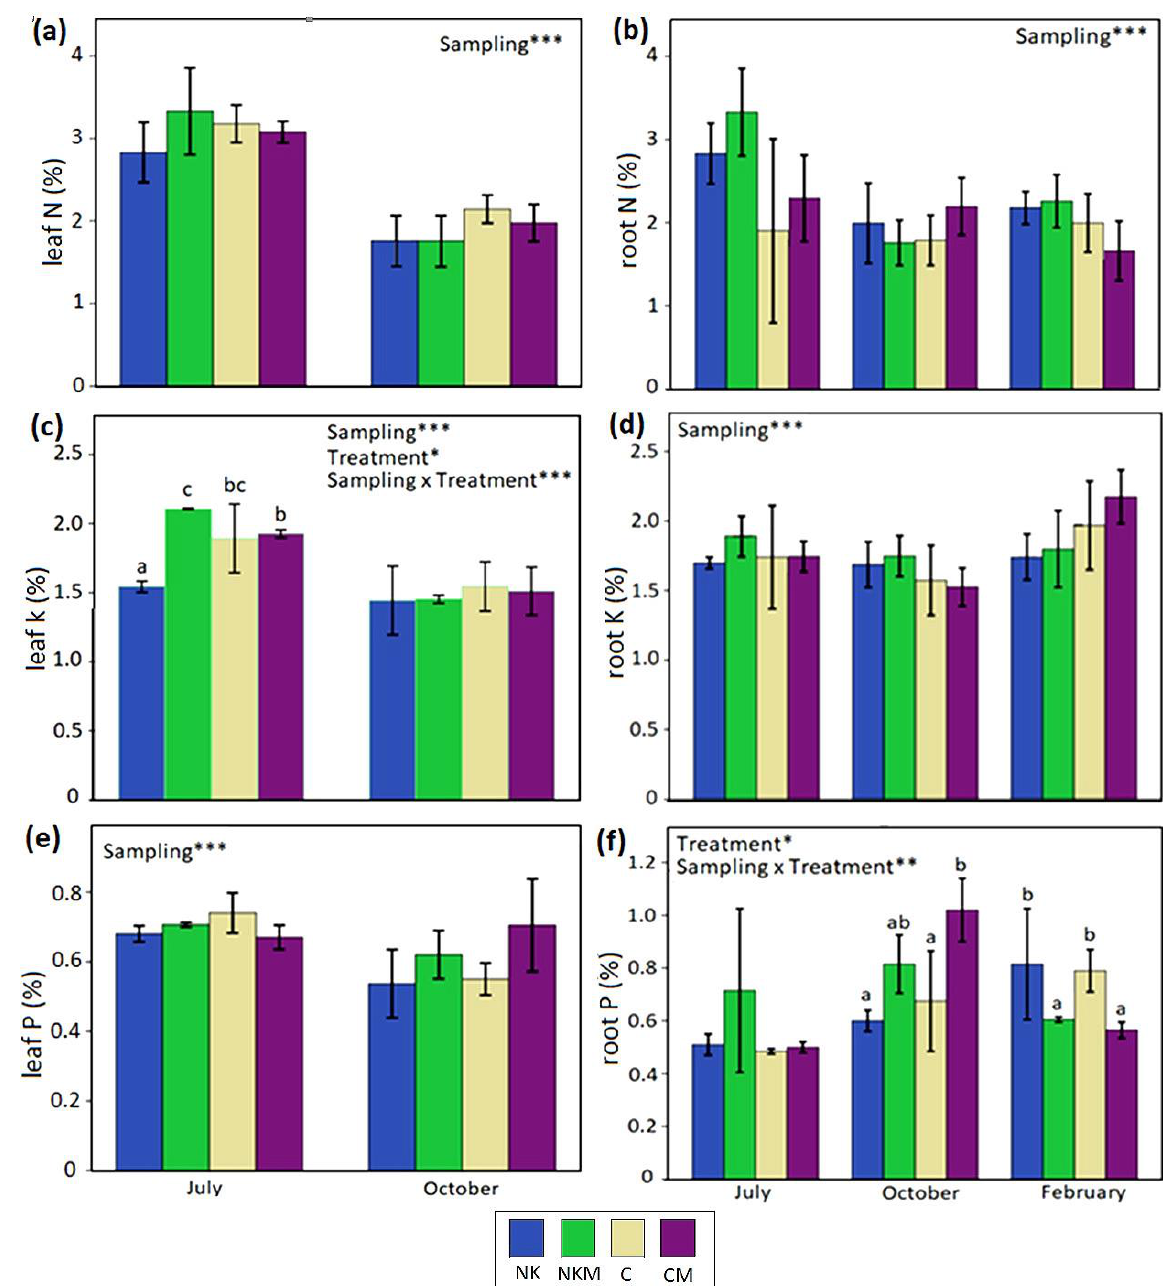
Figure 1. ( a – f ) Mean values (±SE) of leaf N ( a ), leaf K ( c ), leaf P ( e ) and root N ( b ), root K ( d ) and root P ( f ) content, as recorded in July, October and February samplings of all treatment groups (NK: KNO 3 fertilizer; NKM: KNO 3 in combination with PGPR; C (Control): NH 4 NO 3 fertilizer and CM: NH 4 NO 3 fertilizer in combination with PGPR). “Sampling”, “Treatment” and “Sampling × Treatment” on the top of the graphs indicate a significant effect of the sampling period, the treatment or their interactive effect, respectively, as revealed by ANOVA (* p < 0.05, ** p < 0.01, *** p < 0.001). Different superscript letters denote significant differences between treatments (a: corresponds to the lowest value).